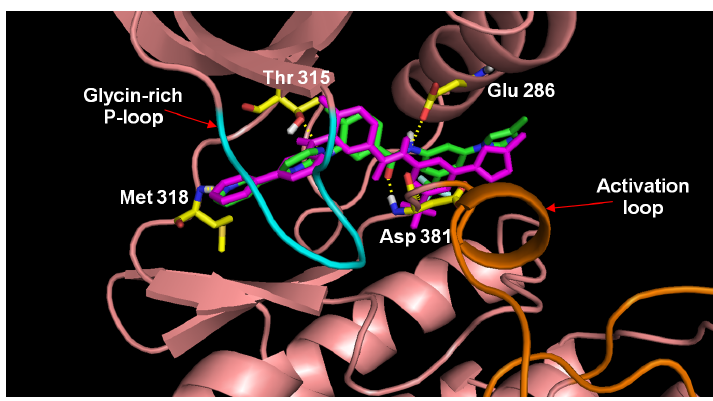
Figure 4. Four hydrogen bonds and one liphophilic bond interactions between regenerated nilotinib and the Abl kinase structure. Fragment 1 of nilotinib is located in a glycine-rich P-loop (cyan color) and fragment 2 of nilotinib is positioned near the activation loop (orange